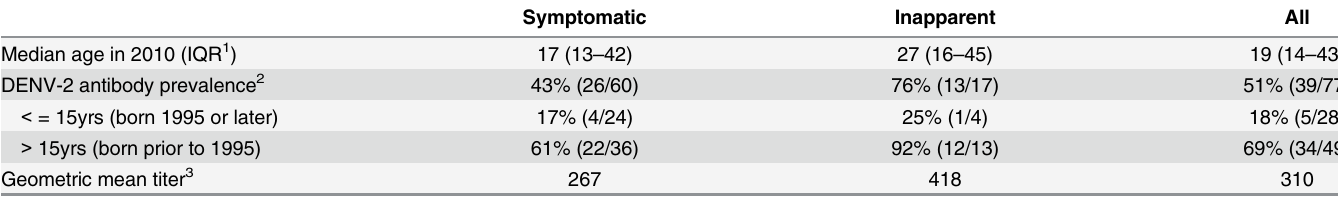
Table 1. Pre-epidemic DENV-2 neutralizing antibody prevalence among symptomatic and inapparent DENV-2 infections.